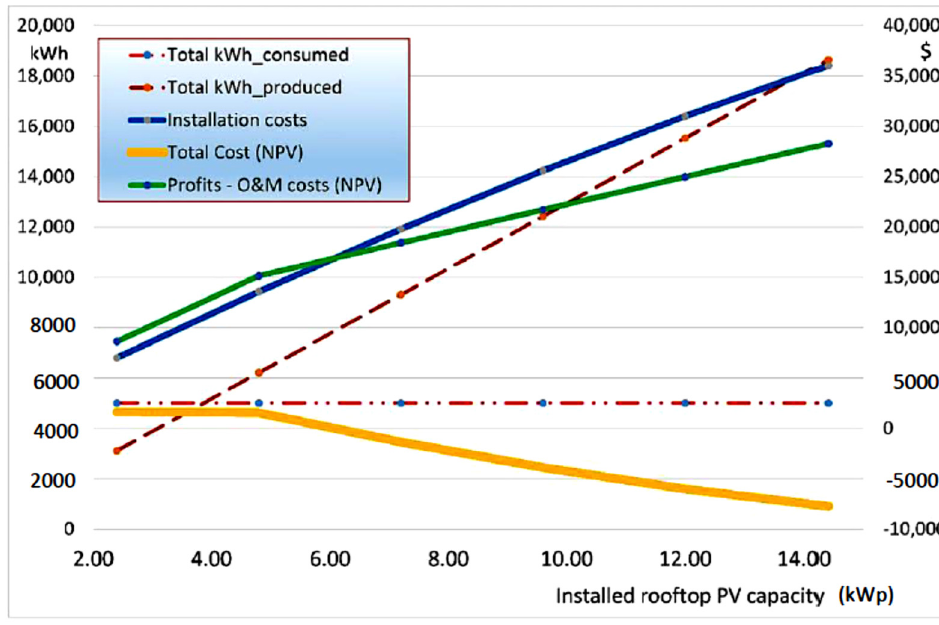
Figure 4. Different system costs with variable capacity of PV panels; reproduced from [148].